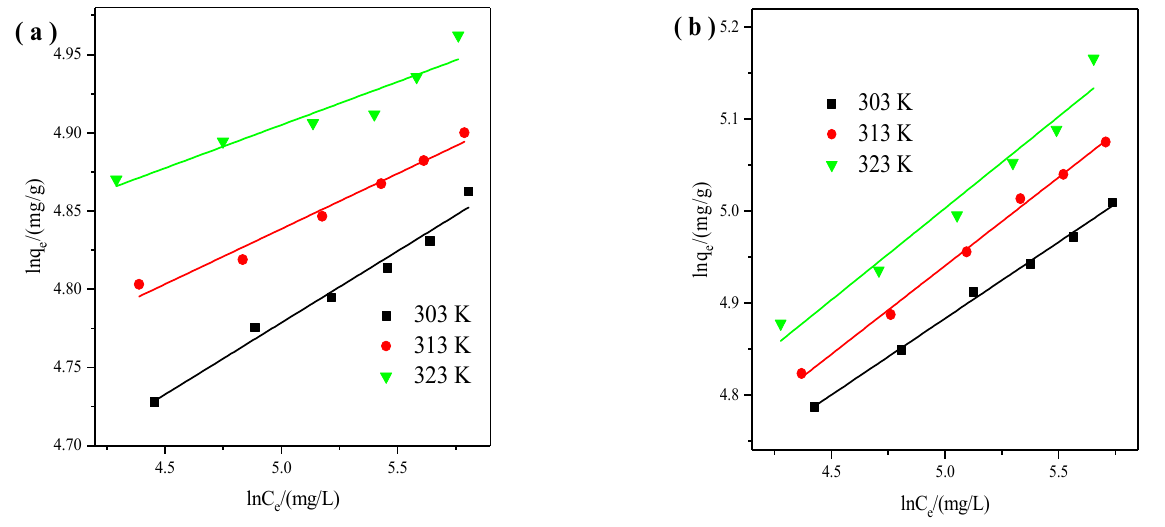
where K F is related to the adsorption capacity, n is related to the adsorption intensity. From data correlation (Figure 5), both n and K F can be determined.